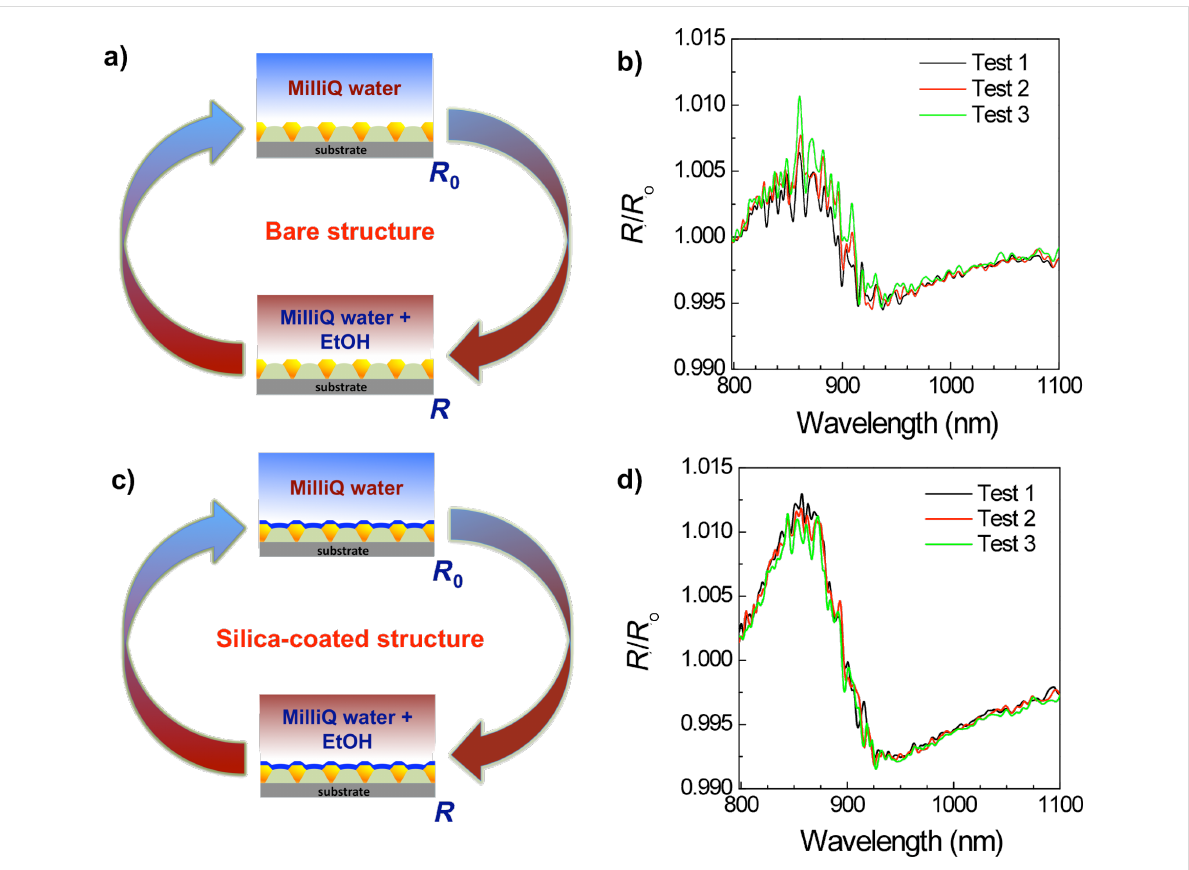
Figure 6: Simplified schemes showing the procedure used to perform the optical sensing and chip regeneration tests for (a) bare (uncoated) and (c) silica-coated structures. Normalized reflectance spectra ( R / R 0 ) of a plasmonic, nanostructured chip for the (b) bare (uncoated) chip, tested with 12 h regeneration time and (d) an ≈ 6 nm thick silica layer coated chip, tested with 30 min regeneration